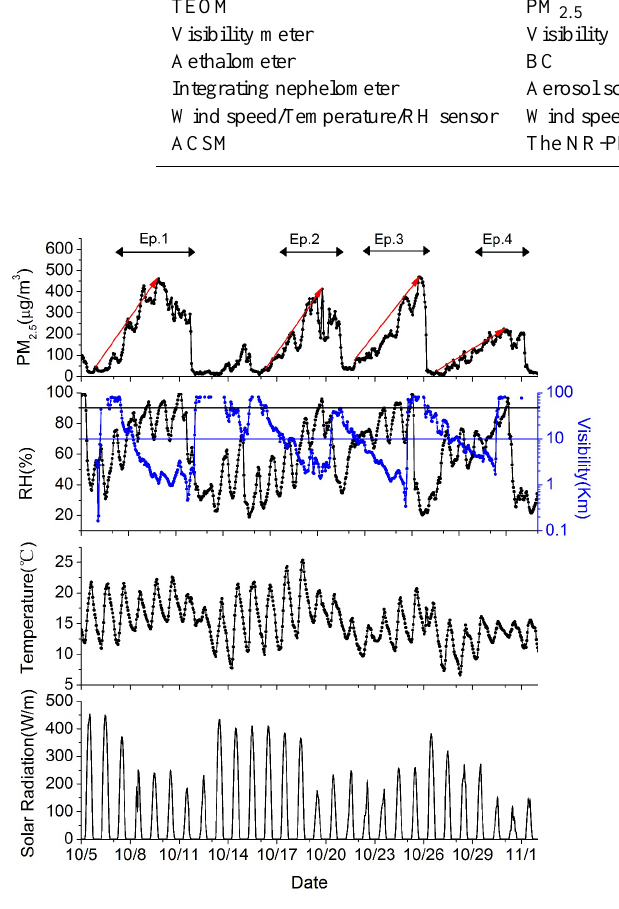
Figure 2. Time series of observed PM 2 . 5 , RH, temperature and so- lar radiation in Beijing from 5 October to 2 November 2014.